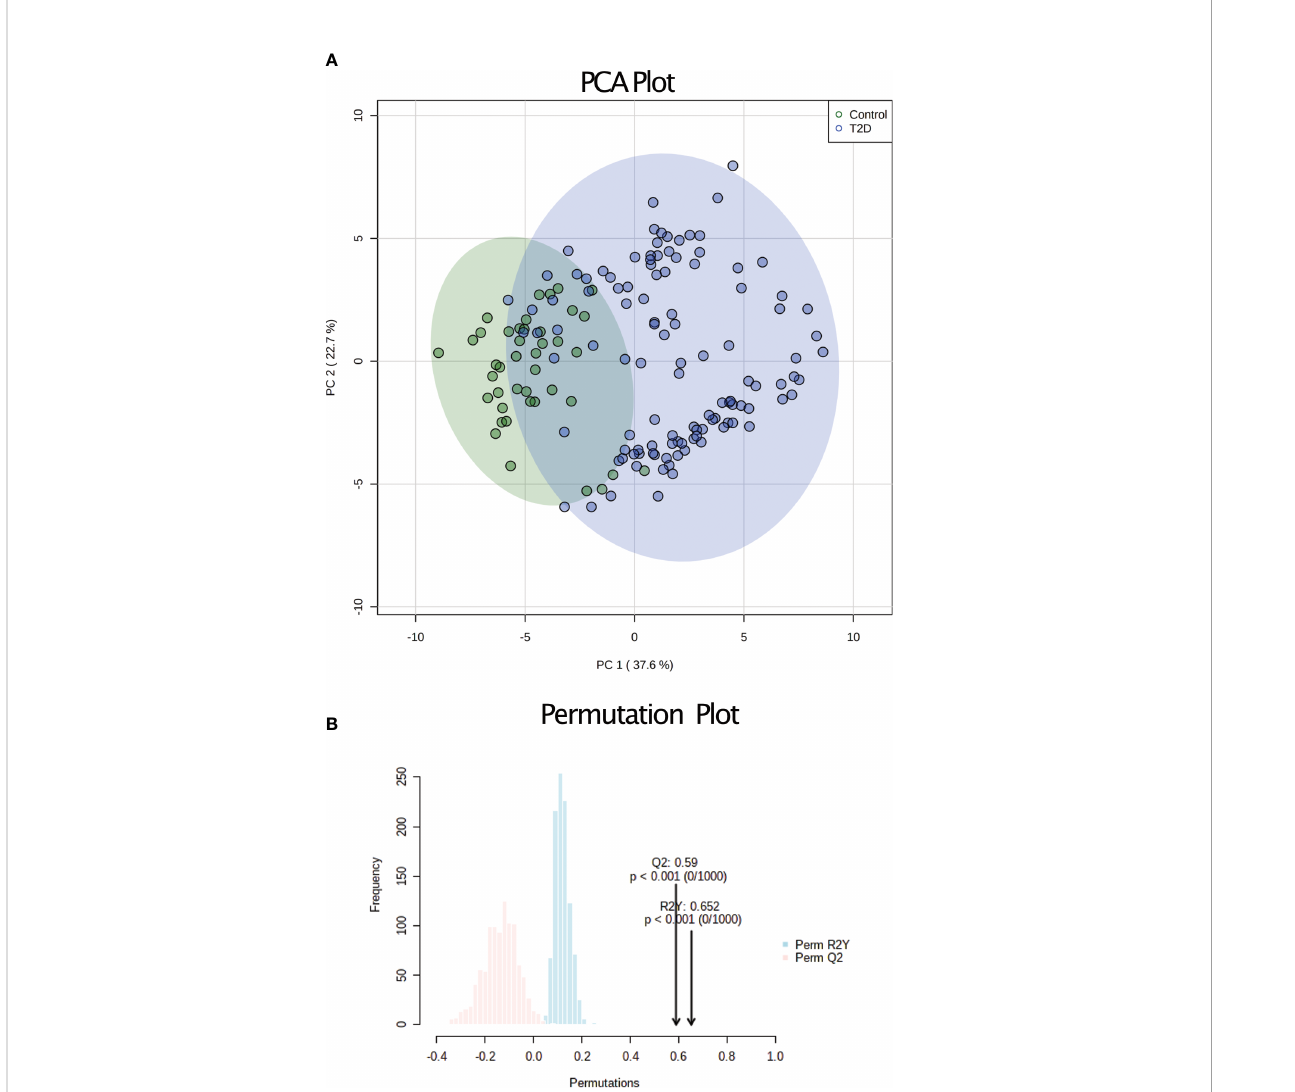
FIGURE 1 Unsupervised analysis of serum metabolomics. (A) PCA analysis based on the 43 metabolites and all 155 samples. The controls are shown in green and the T2D samples in blue (B) Permutation conducted to validate the variation obtained during the PCA. The R2 (shown in blue) and Q2 (shown in red) values indicate the robustness of the PCA